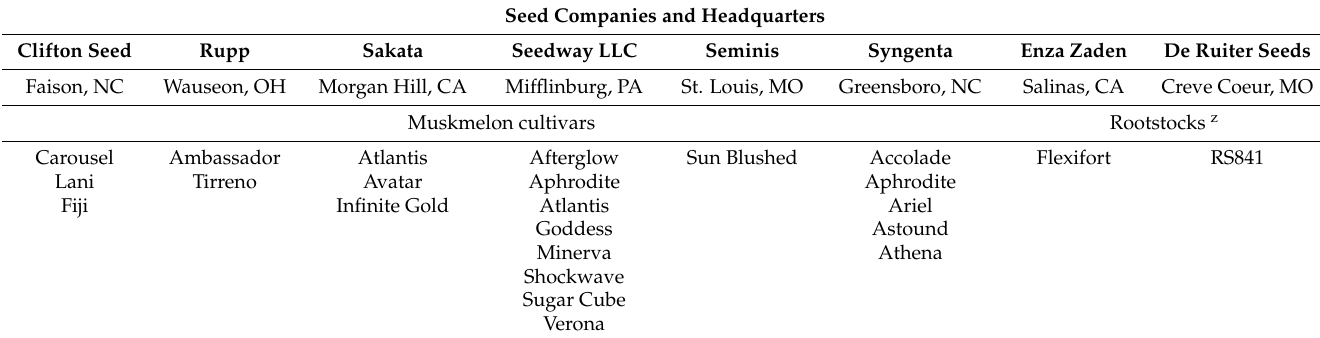
Table 1. Cultivars, rootstocks, and seed sources of muskmelons evaluated at three sites in Pennsylvania in 2018–2019.